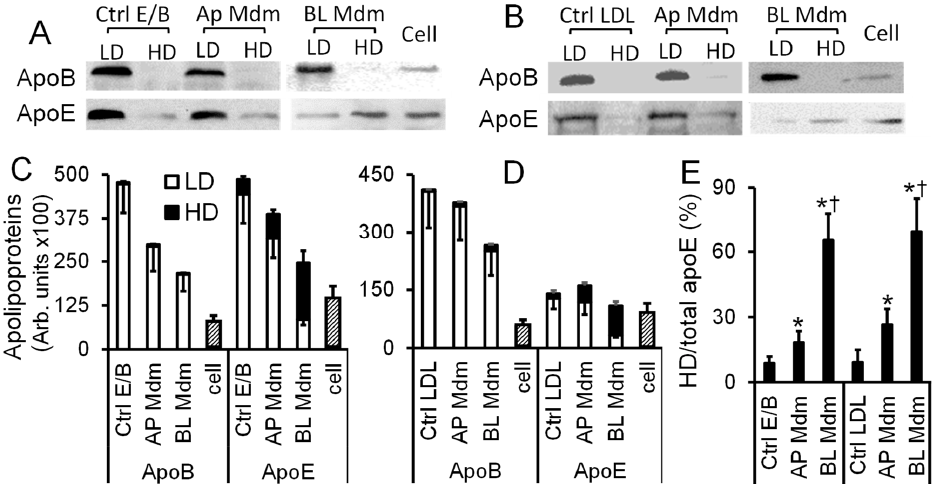
Figure 4. Transendothelial transport of apoB-LPs induced redistribution of apoE, but not apoB, among lipoprotein fractions. The AP side of the MAEC monolayer was incubated with 20 µg/mL of E/B-LPs (E/B) ( A , C ) or LDLs ( B , D ); the BL side was incubated with medium alone for 24 h. The AP and BL media, and 20 µ g of cell-untreated Ctrl E/B or LDLs, were subjected to DG ultracentrifugation. Fractions 1–9 and 10–20 were pooled separately and designated as LD and HD fractions, respectively. Proteins in the LD and HD fractions and the cell lysate were precipitated with 75% methanol for Western blot analysis of apoB and apoE. The protein in the BL medium was pooled from six BL chambers. The level of apoE was expressed by the immunoblot band intensity ( C , D ). ( E ): The %